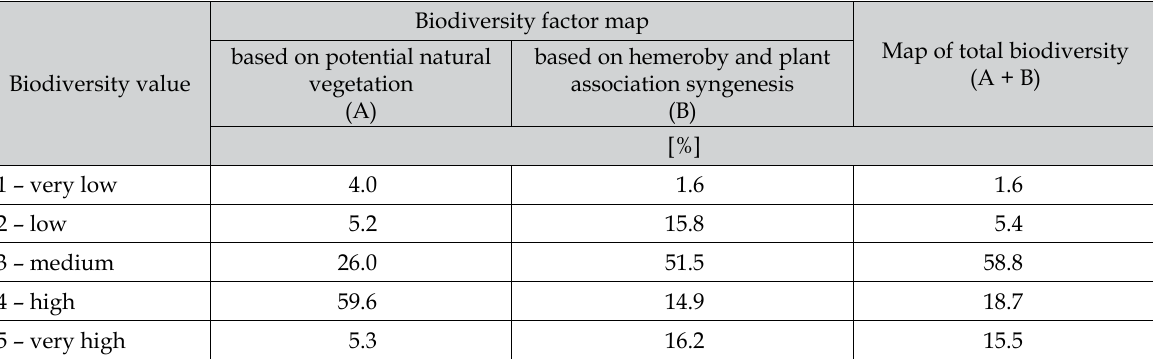
table 4. the percentage of diversified areas in terms of biodiversity values based on: potential natural vegeta- tion (A), hemeroby and plant association syngenesis (B) and total biodiversity (A+B). Biodiversity factor map Map of total biodiversity based on hemeroby and plant association Biodiversity value (A)